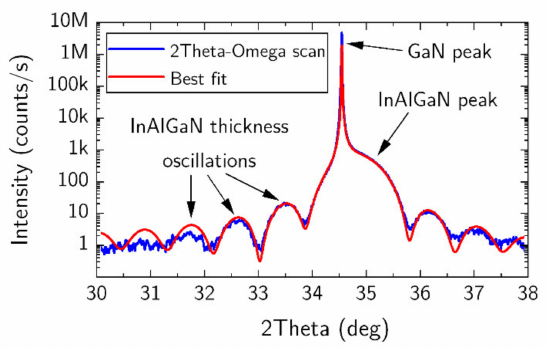
Figure 3. Experimental HR-XRD curve (blue line) and the best fit (red line) of the heterostructure with quaternary barrier composition of 16.5 ± 0.2%, 77.5 ± 0.2%, and 6% for In, Al, and Ga, respectively, and thickness of 8.6